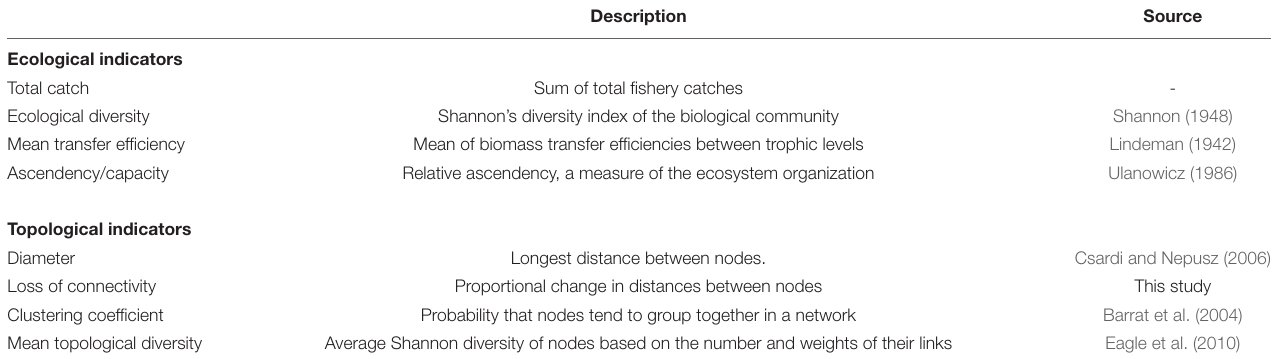
TABLE 2 | Ecological and topological indicators used for analyzing the food web structure and